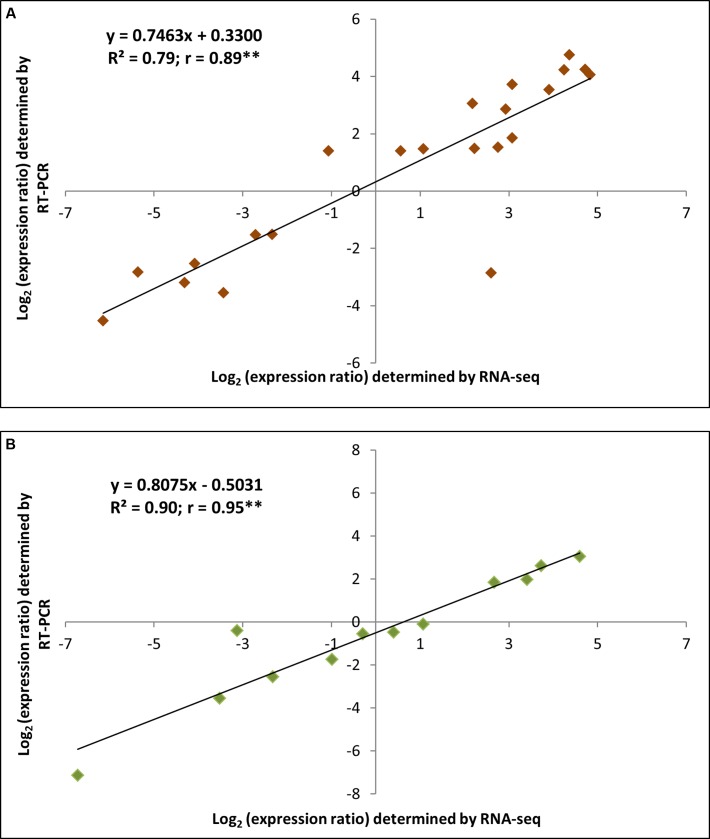
Linear regressions involving the RNA sequencing data and the RT-qPCR validation data expressed in terms of Log2FC. The fold change (FC) was calculated as the ratio between the drought-stressed and control plants. (A,B) indicate roots and leaves, respectively. ∗∗Significant Pearson’s correlation coefficient at P ≤ 0.01.